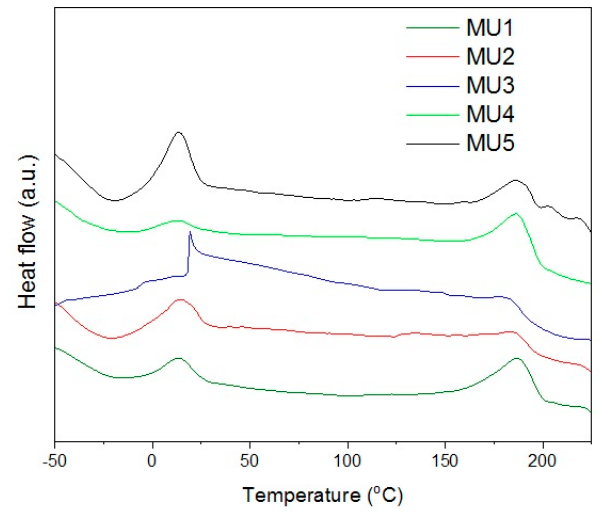
Figure 7. Second heating curve from the DCS.